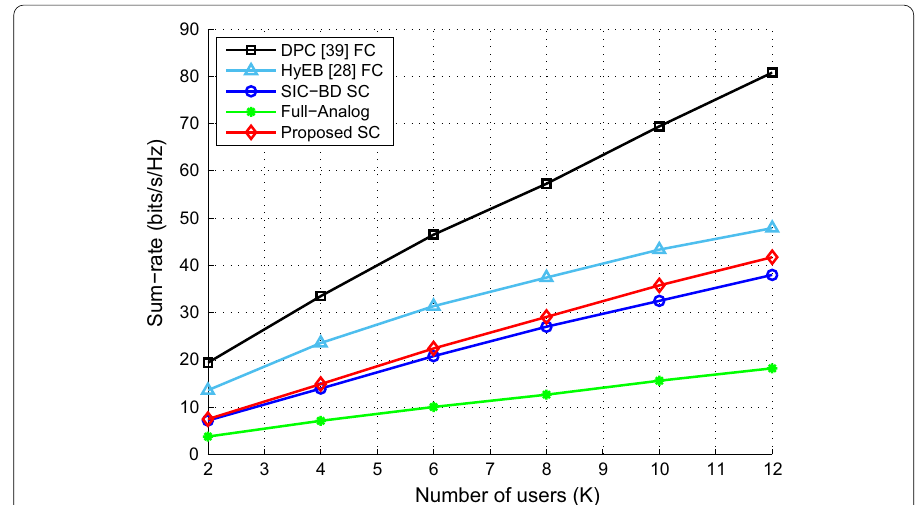
Fig. 6 The sum rate comparison for different hybrid precoding schemes versus the numbers of users. It compares the sum rate performance of different precoding schemes versus the number of users with SNR 5 dB, where the number of users changes from 2 to 12